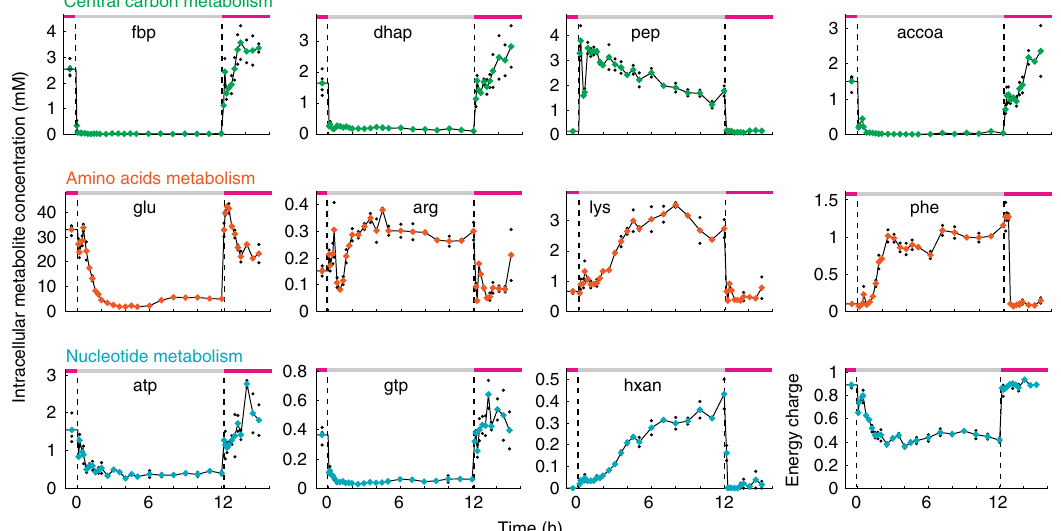
Fig. 2 Examples of metabolite concentration changes during the growth – starvation-growth switch. Absolute concentration of metabolites in central carbon metabolism (green), amino acid metabolism (orange), and nucleotide metabolism (blue). The dashed lines indicate the starvation and growth phases. Black dots show concentrations of two replicates per time point (four at the fi rst time point), colored dots are the mean. The energy charge is calculated from the concentration of ATP, ADP, and AMP. fbp fructose-1,6-bisphosphate, dhap dihydroxyacetone phosphate, pep phosphoenolpyruvate, accoa acetyl- coenzyme A, glu glutamate, arg arginine, lys lysine, phe phenylalanine, atp adenosine triphosphate, gtp guanosine triphosphate, hxan hypoxanthine. Source data are provided as a Source Data fi